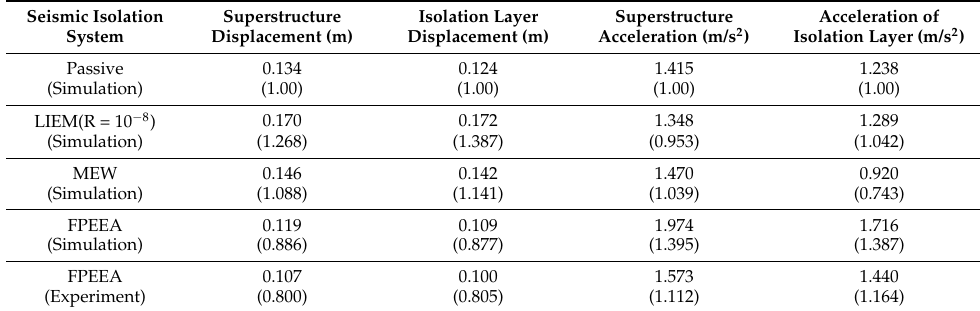
Table 11. Maximum responses of TCU102 (PGA = 0.1 g) earthquake.